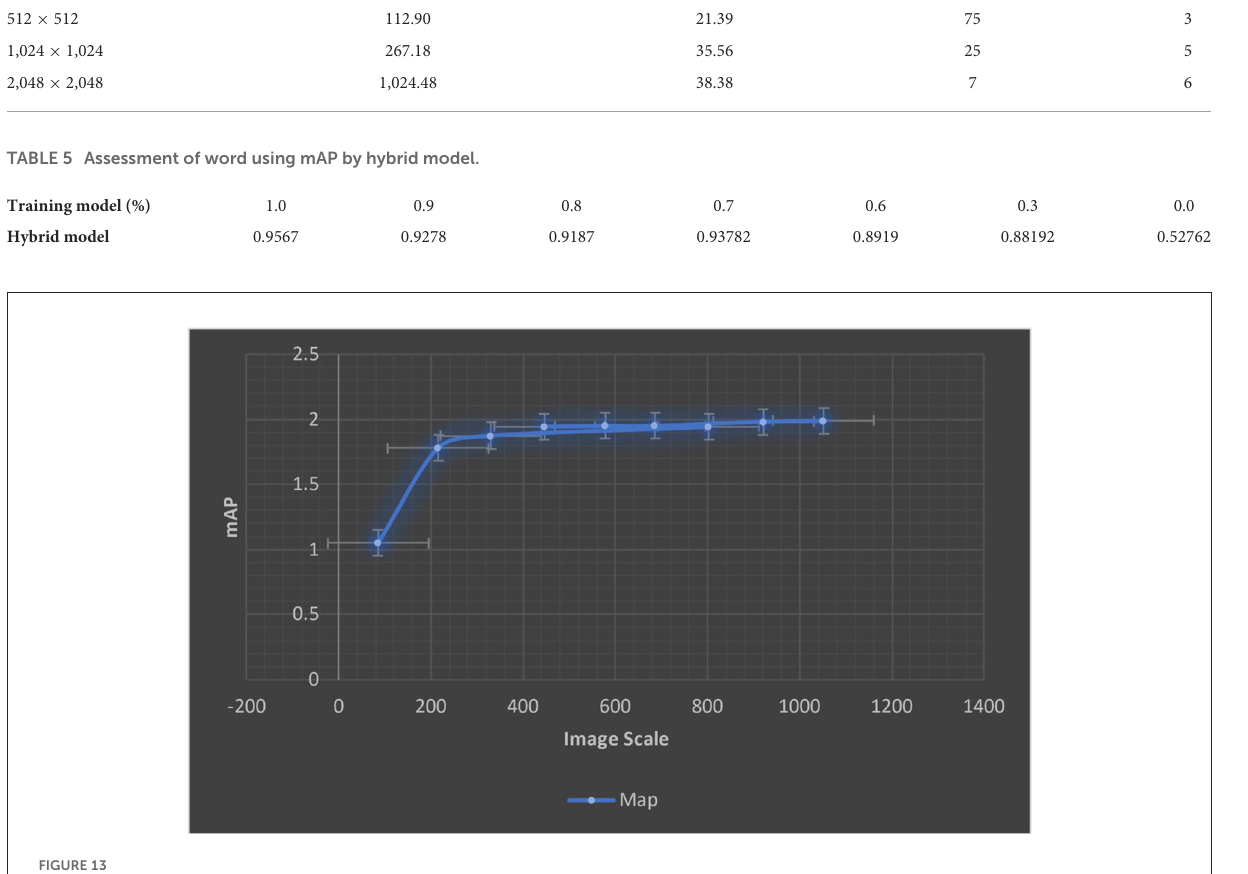
TABLE 4 Test setup for hybrid model.